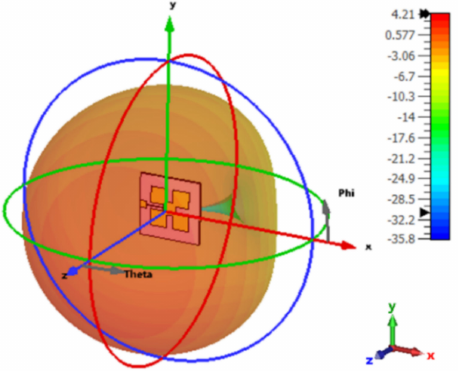
Figure 3. The simulated 3D radiation pattern of Ant 1.